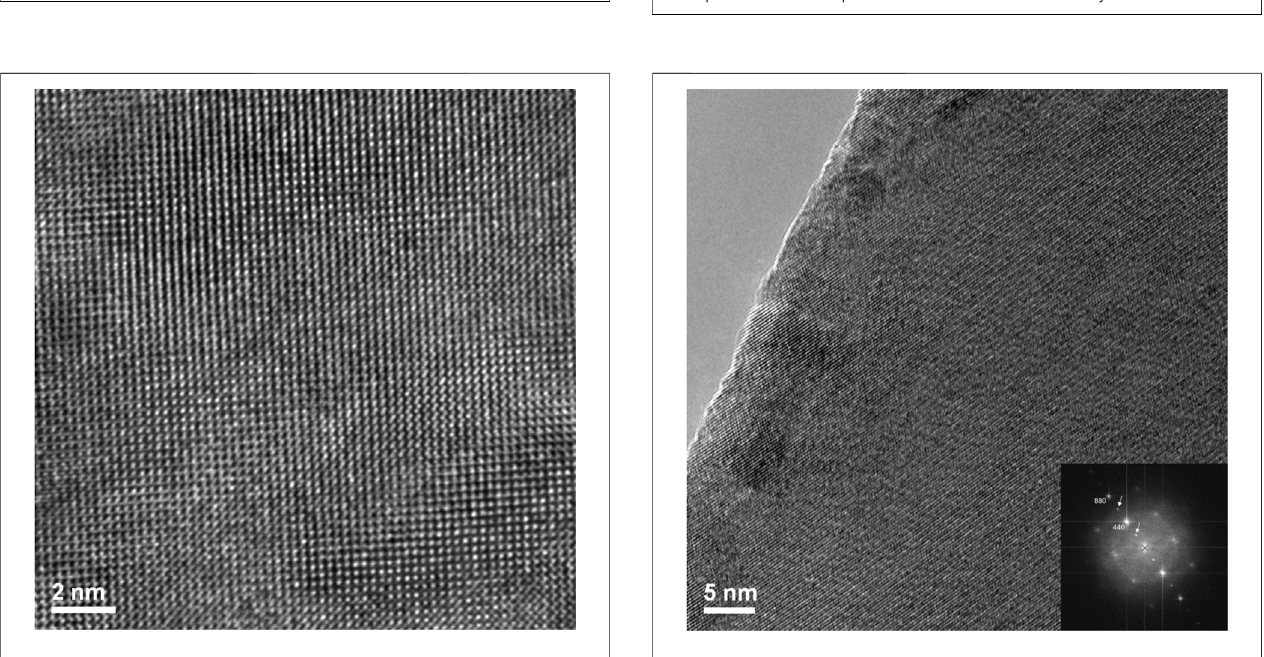
FIGURE 13 | High resolution image of lower circled FIB lift out area of irradiated Nd 2 Zr 2 O 7 ( Figure 12 ) showing intertwined regions of disorder. The FFTinsetofthehigh-resolutionimageisvieweddownthe[ − 1 − 11],thediffuse scattering is indicative of the areas of disorder that can be seen in the image. Superlattice re fl ections are indicated by the